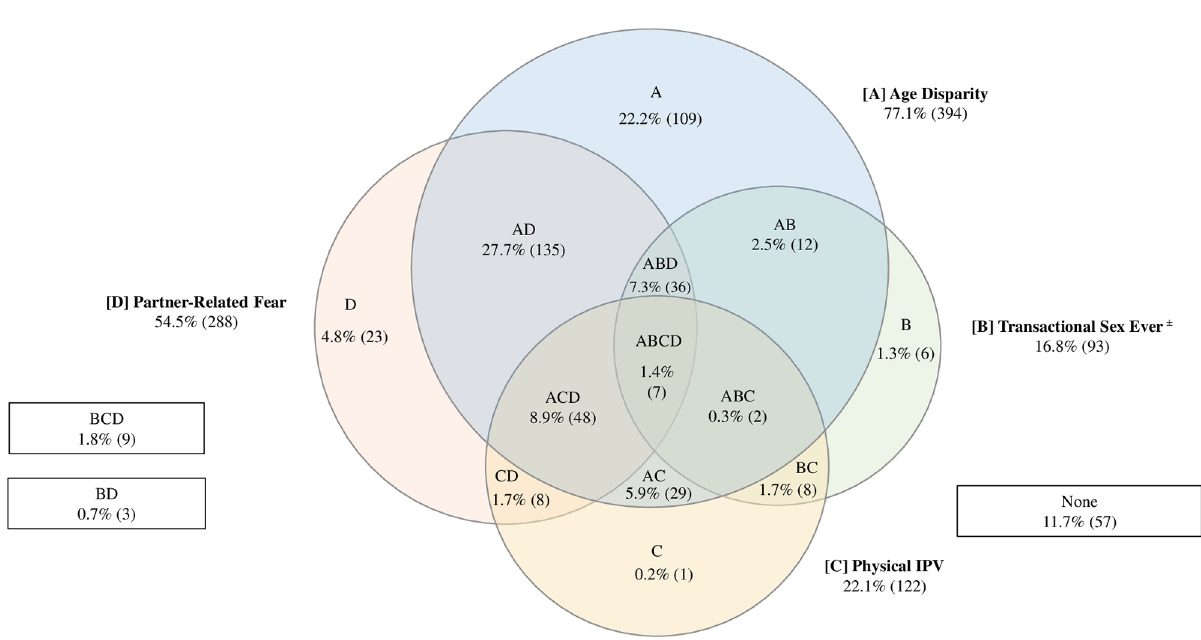
Fig 2. Venn diagram depicting gendered power imbalances at the interpersonal level in Abidjan, weighted (n = 555) / . [A] Age disparity. [B] Transactional sex. [C] Physical Intimate Partner Violence (IPV). [D] Partner-related fear. / cells are mutually exclusive; not proportionate to size; numbers fluctuate due to small amounts of missing data. ± Indicates lifetime measure, not specific to current partnership.